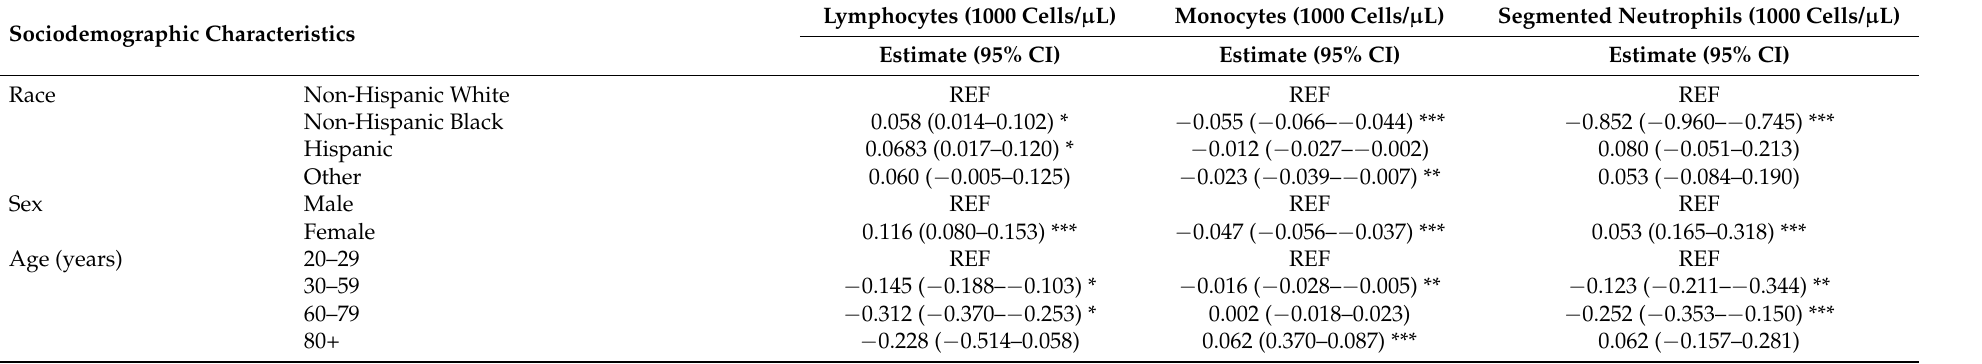
Table 3. Multivariable analyses of inflammatory markers of the U.S. population: NHANES